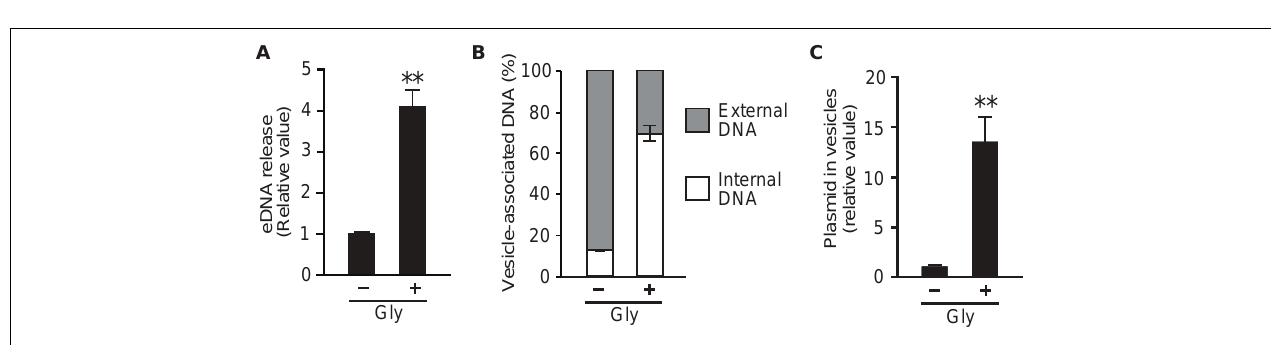
FIGURE 3 | Vesicle formation was increased by glycine. (A) Vesicle formation of E. coli BW25113/pUC19 in the absence (-Gly) and presence (+ Gly) of 1% glycine. The amount of vesicles extracted from the supernatants was normalized to the cell density, and each value presented is relative to that of control. * *P < 0.005 compared to WT. (B) E. coli BW25113 grown with and without 1% glycine was negative-stained and observed by transmission electron microscopy. Black arrows indicate vesicles. Scale bars are 1 µ m. (C) Nano-tracking analysis of vesicles from E. coli BW25113 WT (with and without glycine) and (cid:49) nlpI . Blue numbers indicate the size (nm) of peaks. Each sample was measured three times.